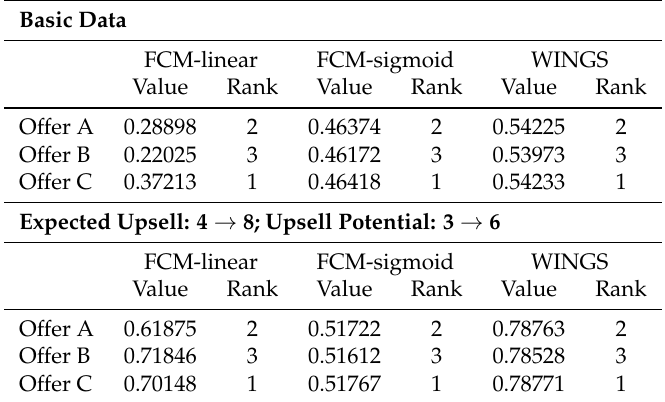
Table 5. FCM and WINGS Strategic Effect—results of sensitivity